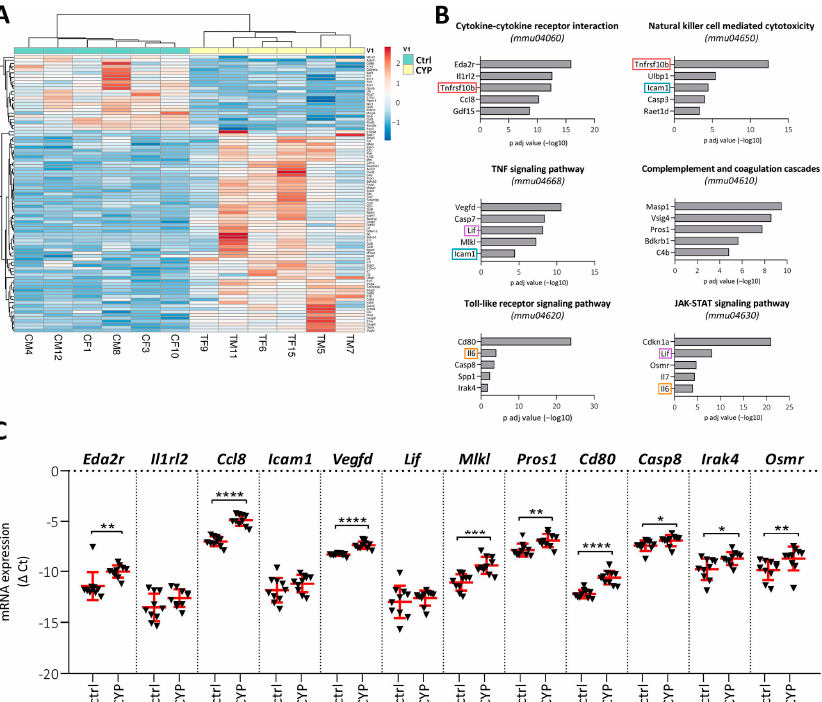
Figure 3. Effects of CYP treatment on the innate immune response in mouse bladders. ( A ) Heatmap showing DEGs ( n = 89) with p adj < 0.05 detected in the enriched KEGG pathways of innate immun- ity response comparing the CYP (yellow; n = 6 animals) vs. Ctrl (green; n = 6 animals) groups. Both the rows and columns are clustered using correlation distance and average linkage. Lower expres- sion is marked in blue; higher expression is marked in red. CM: Ctrl male; CF: Ctrl female; TM: CYP- treated male; TF: CYP-treated female. ( B ) A graphical representation of the five most significantly DEGs in each enriched pathway of innate immunity. Shown are the − log10 of the p adj values of the transcripts in the CYP vs. Ctrl group of animals. Circled are DEGs enriched in more than one path- way. ( C ) qPCR validation of the selected DEGs shown in ( B ), confirming their upregulation in the CYP vs. Ctrl group. Shown are the means ± SD of negative Δ Ct determined for 10 animals per group. The qPCR analysis was not reliable for some DEGs ( Tnfrsf10b , Gdf15 , Ulbp1 , Casp3 , Raet1d , Casp7 , Masp1 , Vsig4 , Bdkrb1 , C4b , Il6 , Spp1 , Cdkn1a , Il7 ), therefore the results are not presented. * p < 0.05; ** p < 0.01; *** p < 0.001; **** p < 0.0001.